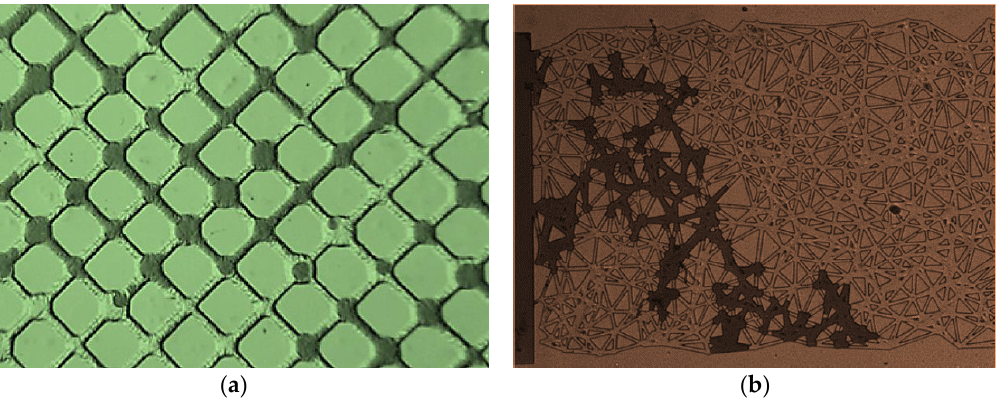
Figure 10. Two instances of micromodels applied to study dynamic nonequilibrium effects under transient two-phase displacement process using visualization techniques (dark and light in the flow conduits indicating two immiscible fluids): ( a ) the glass-etched micromodel [204]; ( b ) the polydimethylsiloxane (PDMS) micromodel [205].